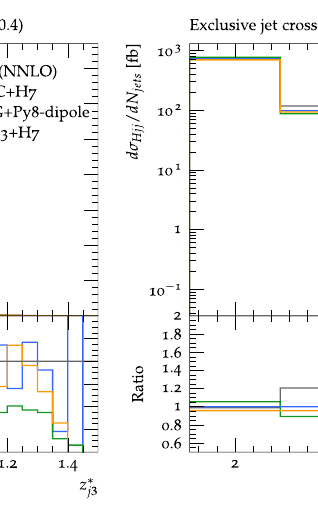
using using a dipole recoil scheme, respectively. Also shown are the NNLO-QCD predictions obtained with proVBFH . The ratio shown in the exclusive number of jets plots is taken with respect to the Mad- Graph5_aMC@NLO prediction